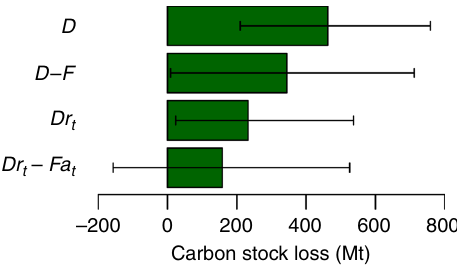
Fig. 1 Global mangrove carbon stock loss between 1996 and 2016 under different estimation methods. Carbon at risk of loss due to mangrove deforestation ( D ), net loss of carbon estimated assuming 100% carbon loss and gain rates ( D − F ), loss of carbon due to deforestation after accounting for carbon loss rates ( Dr t ), net loss in mangrove carbon stock after accounting for forestation and carbon loss and accumulation rates ( Dr t − Fa t ). Error bars indicate 95% bootstrap simulation con fi dence intervals